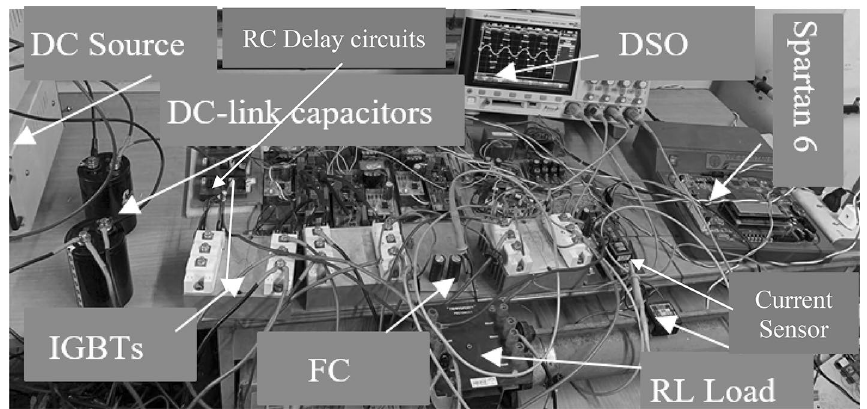
Figure 11. Prototype model of proposed 9L